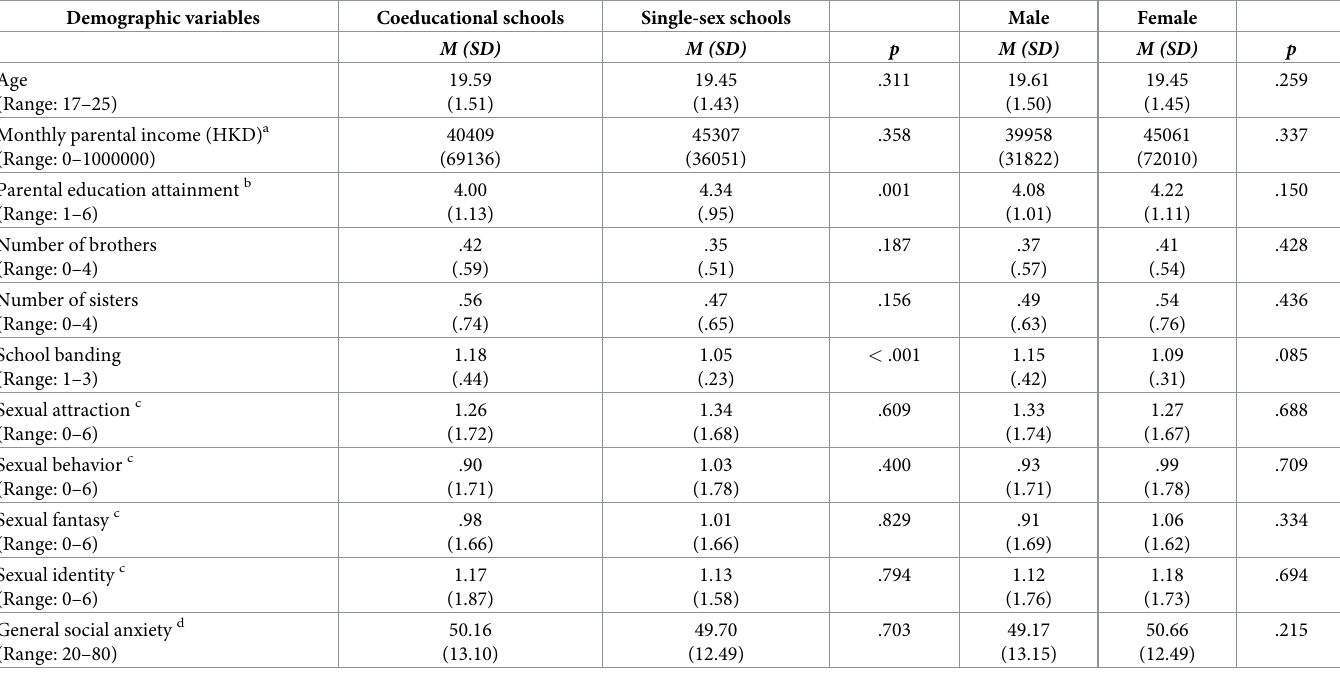
Table 6. Participant characteristics by school type and student gender (Study 2: College sample). Demographic